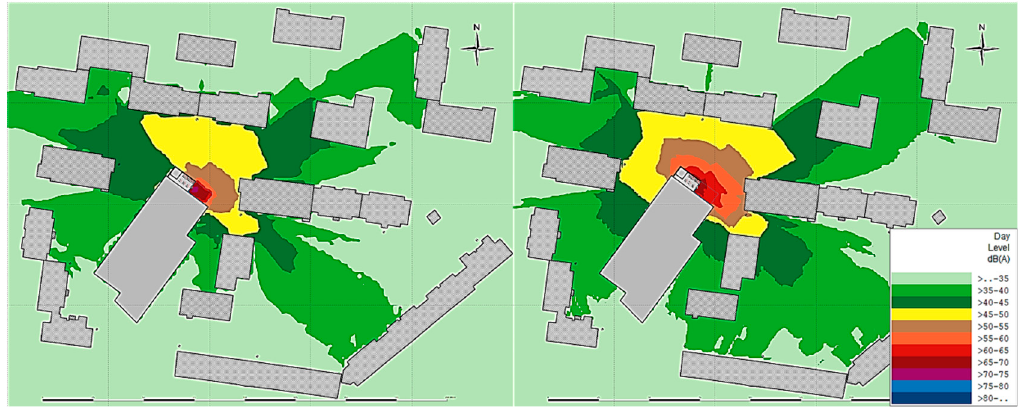
Figure 8. Scenario 4 with a supply ramp inside a construction—Lday with all noise sources ( left : 4 m, right : 10 m).